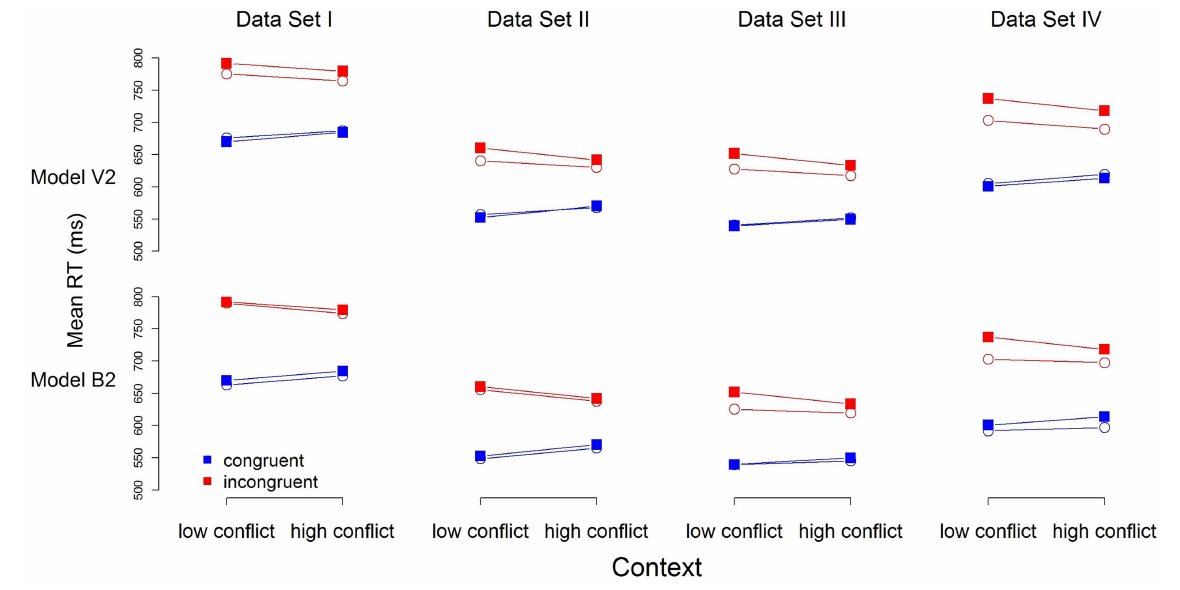
FIGURE 3 | Observed (filled squares) and predicted (open circles) mean RT for each of the four data sets. Note: RTs were calculated in a manner similar to that in Figure 1B , with the exception that the first trial of each block was not excluded.